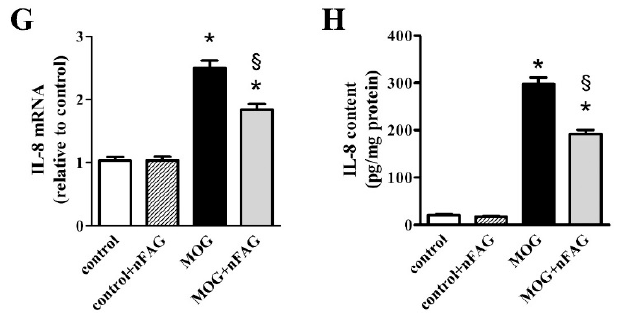
Figure 2. nFAG dietary supplementation reduces MOG-induced upregulation of markers of inflammation including tumor necrosis factor- α (TNF- α ; A , B ); interleukin (IL)-1 β ( C , D ); IL-6 ( E , F ) and IL-8 ( G , H ). Levels were evaluated in control and MOG-treated mice, without or with nFAG dietary supplementation. Transcripts ( A , C , E , G ) were evaluated by relative quantification with quantitative real-time PCR (qPCR). Data were analyzed by the formula 2 −ΔΔ CT using Rpl13a as the internal standard. Proteins ( B , D , F , H ) were evaluated by ELISA (R&D Systems, Minneapolis, MN, USA for TNF- α , IL-1 β , and IL-6; MyBioSource, San Diego, CA, USA for IL-8). Data are shown as the mean ± S.E.M. ( n = 9 for each experimental group). * p < 0.001 versus control. § p < 0.001 versus MOG (one-way ANOVA followed by the Newman-Keuls multiple comparison post-hoc test). White bars, control mice; dashed bars, control mice with nFAG dietary supplementation; black bars, MOG-treated mice; grey bars, MOG-treated mice with nFAG dietary supplementation. Additional inflammatory markers including ICAM-1, GFAP, and iNOS were also evaluated at the transcript and the protein level. As shown in Figure 3, we found that ICAM-1 (Figure 3A), GFAP (Figure 3C), and iNOS (Figure 3E) transcripts increased to approximately 3.5-, 3.7- and 3.4-fold ( p < 0.001), whereas their protein levels (Figure 3B,D,F) increased to approximately 4.6-, 2.2- and 3.1-fold ( p < 0.001). nFAG supplementation did not affect the levels of inflammatory markers in controls, whereas significantly decreased their upregulated levels in MOG-treated mice with ICAM-1, GFAP, and iNOS transcripts reduced by nearly 1.6-, 1.5- and 1.6-fold ( p < 0.001). At the protein level, nFAG reduced ICAM-1, GFAP, and iNOS by about 1.8-, 1.6- and 1.6-fold ( p < 0.001).